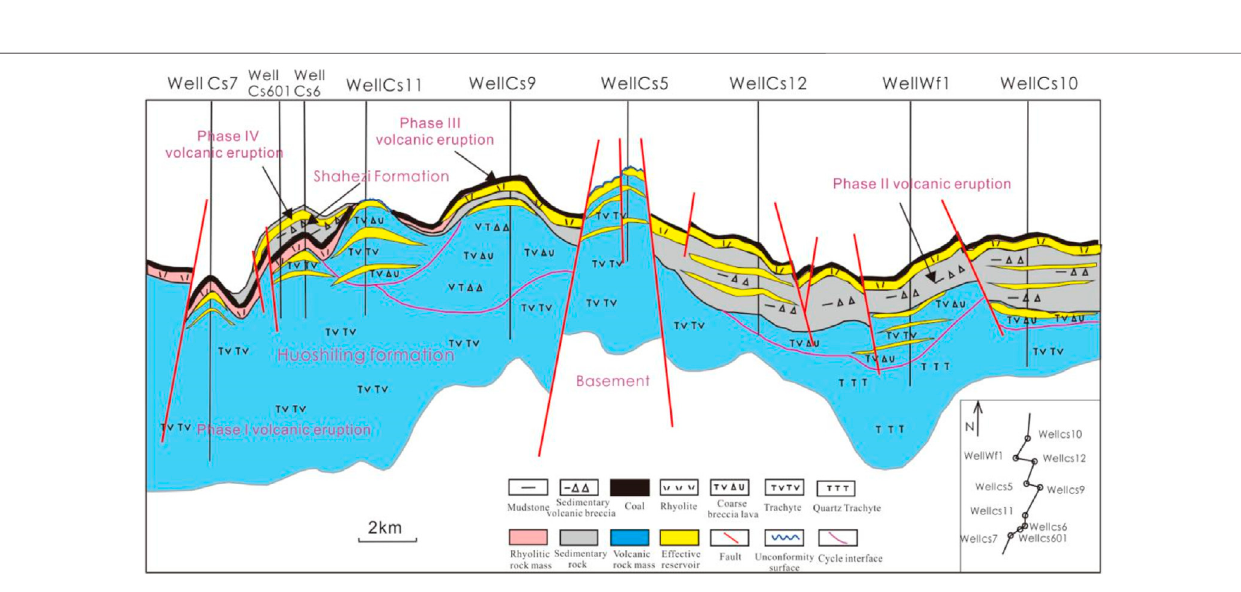
Frontiers in Earth Science |